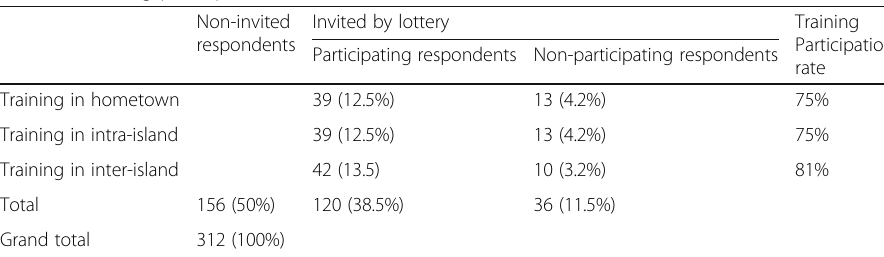
Non-invited Invited by lottery Training respondents